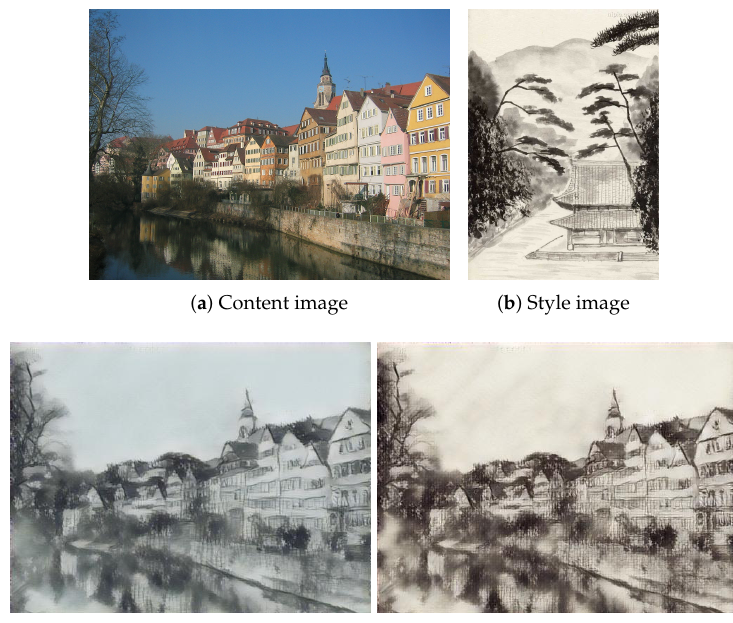
Figure 4. Comparison results with or without ink painting training dataset.